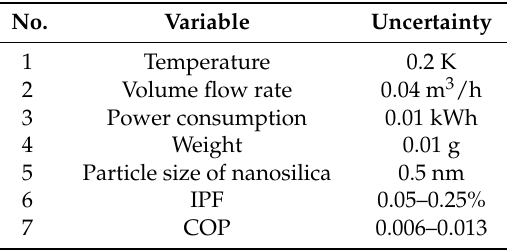
Table 2. Value of